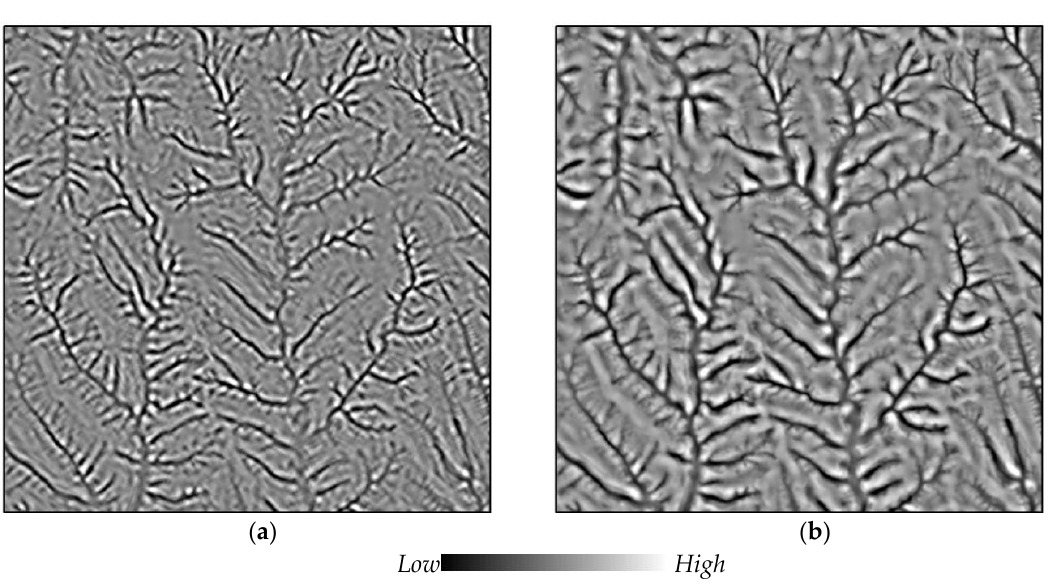
Figure A2. Highest detail component before and after filter bank. ( a ) Before filter bank; ( b ) After filter bank.